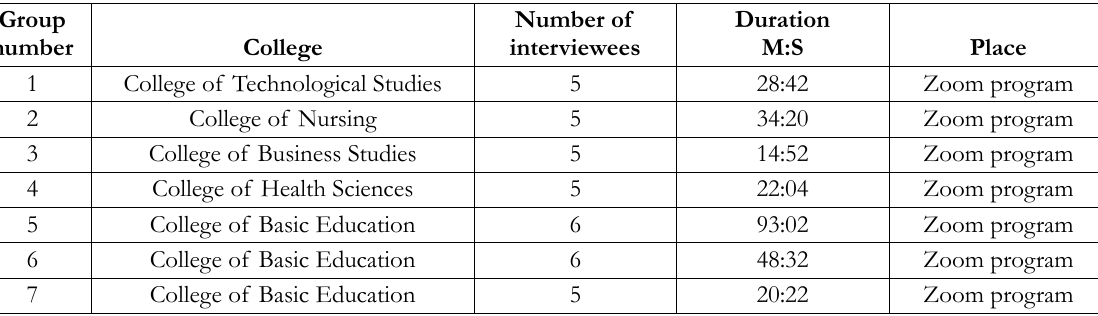
Table 3. General information of focus group interviews